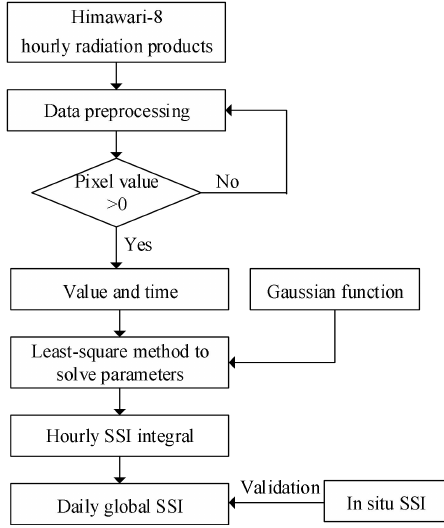
Figure 2 . Flowchart of estimating the daily global SSI from the Himawari-8 hourly radiation